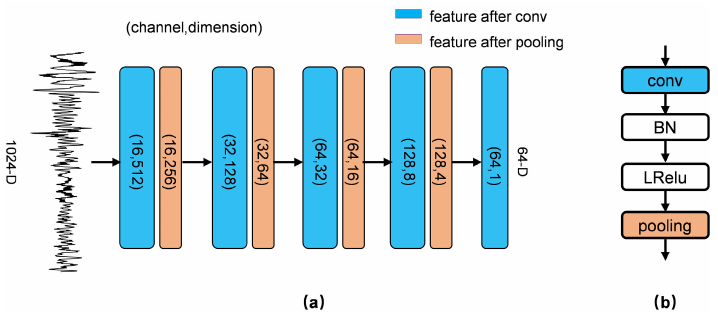
Figure 5. ( a ) The structure of the 1D-CNN encoder. It is composed of 5 convolutional layers and 4 pooling layers. Eight-length convolutional kernels are used at the first four layers, while 4-length kernels are used at the last layer. ( b ) We perform batch normalization (BN) and a leaky rectified linear unit (LRelu) function after each convolutional